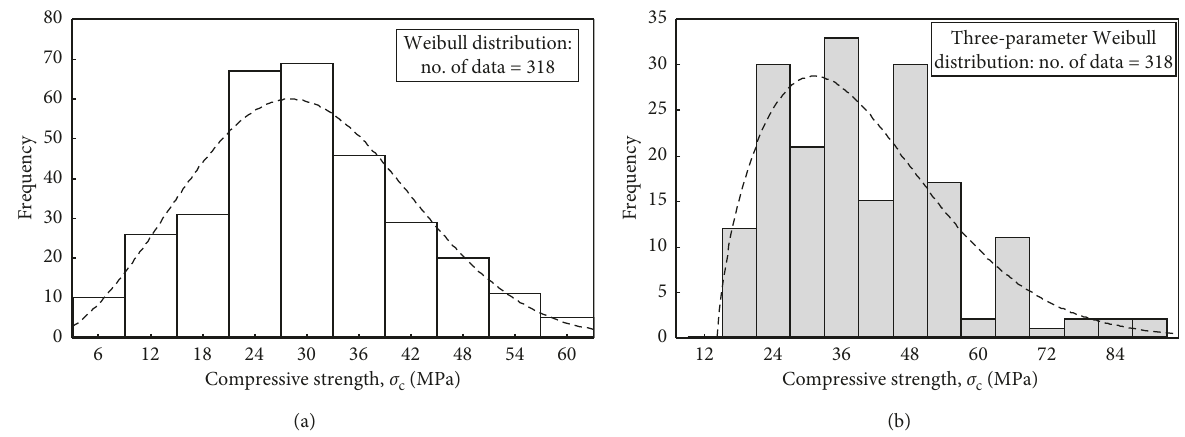
Figure 3: Statistical distribution of the compressive strength for (a) cement mortar and (b) cement mortar modified with fly ash (FA) up to 90 days of curing.